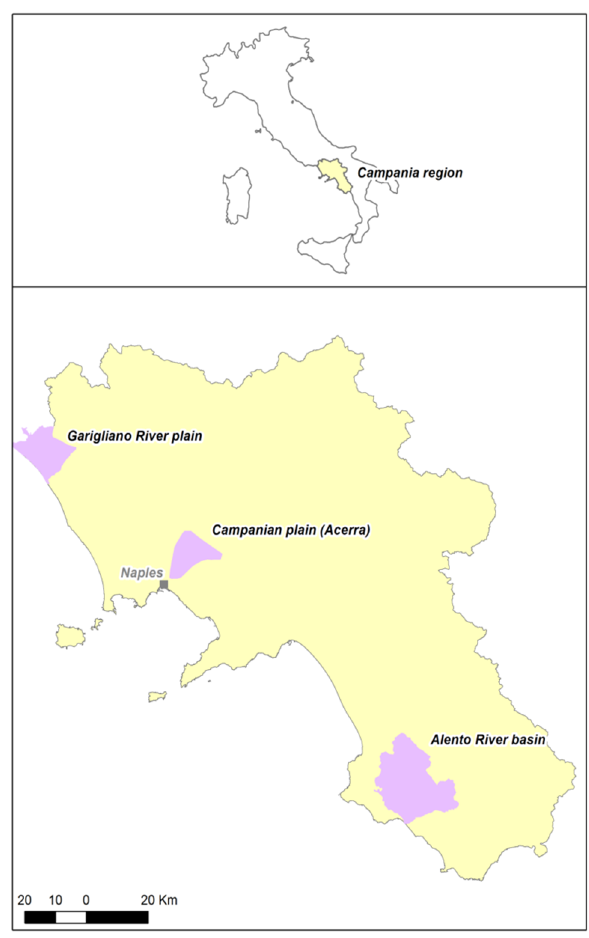
Figure 1. Locations of the study areas in Campania region (Italy). Light yellow signifies the region (source: ISTAT: Italian Institute of Statistics) and violet signifies the study areas.